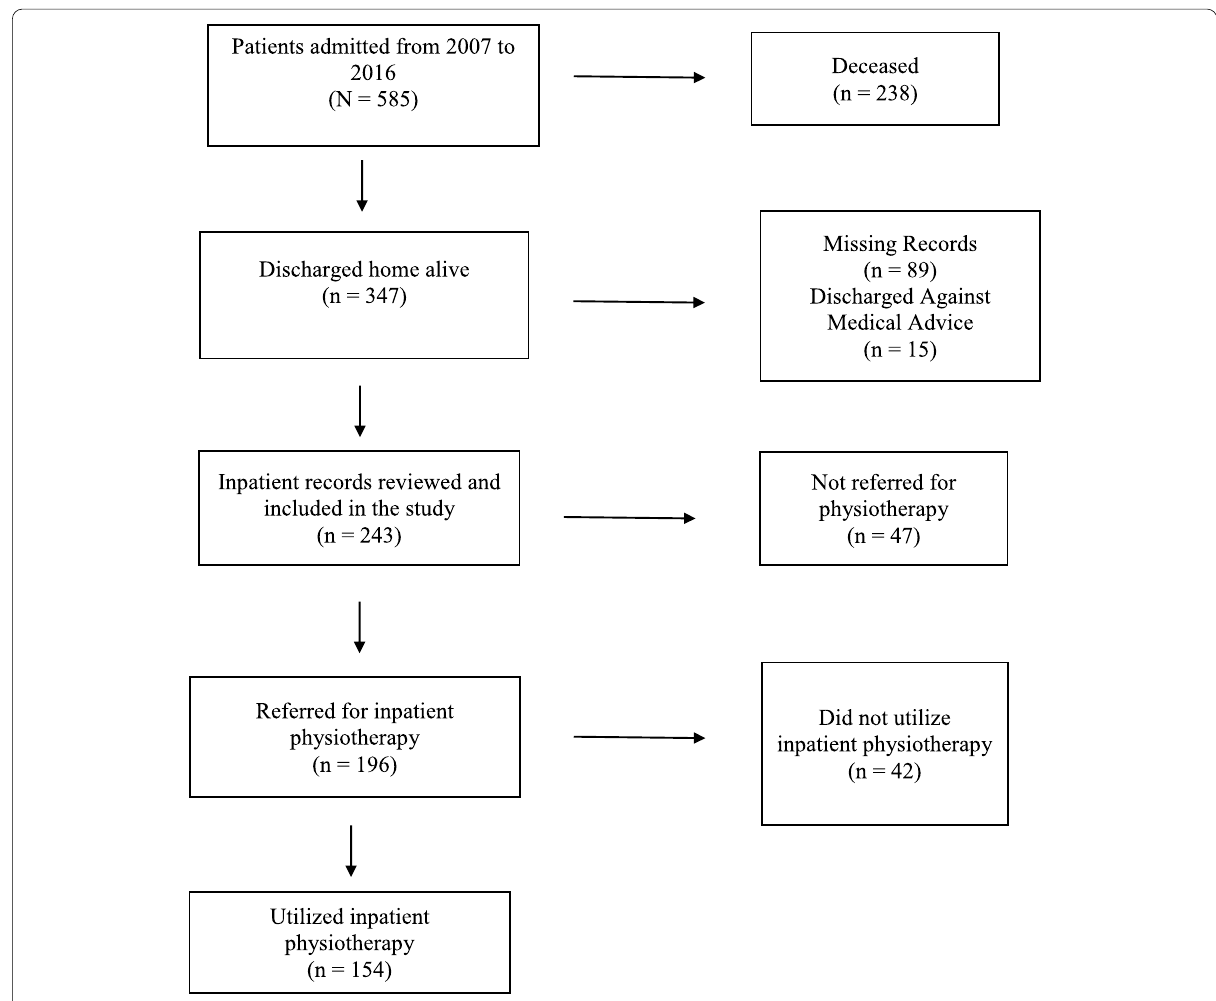
Fig. 1 Flowchart of medical records of patients with